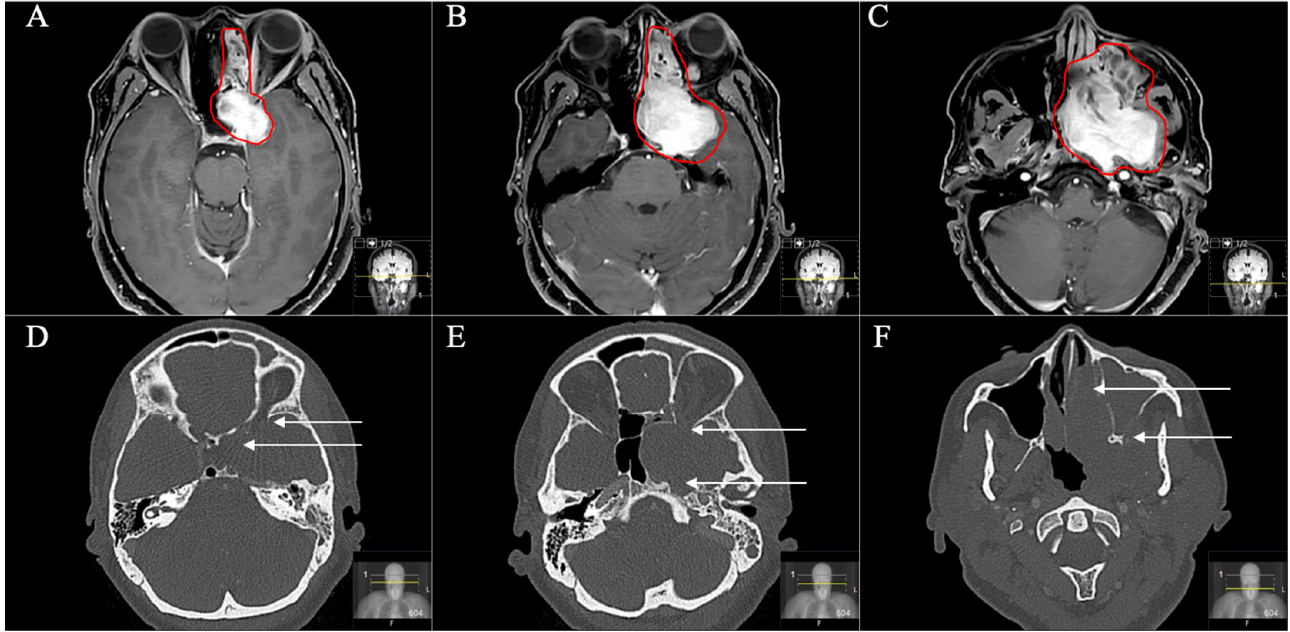
Figure 8. Illustration displaying surgical techniques and outcomes for each tumor type (according to Samii). STA = Subtemporal approach. TNA = Transnasal endoscopic approach. RSA = Retrosigmoid approach. GTR = Gross total resection. STR = Subtotal resection.